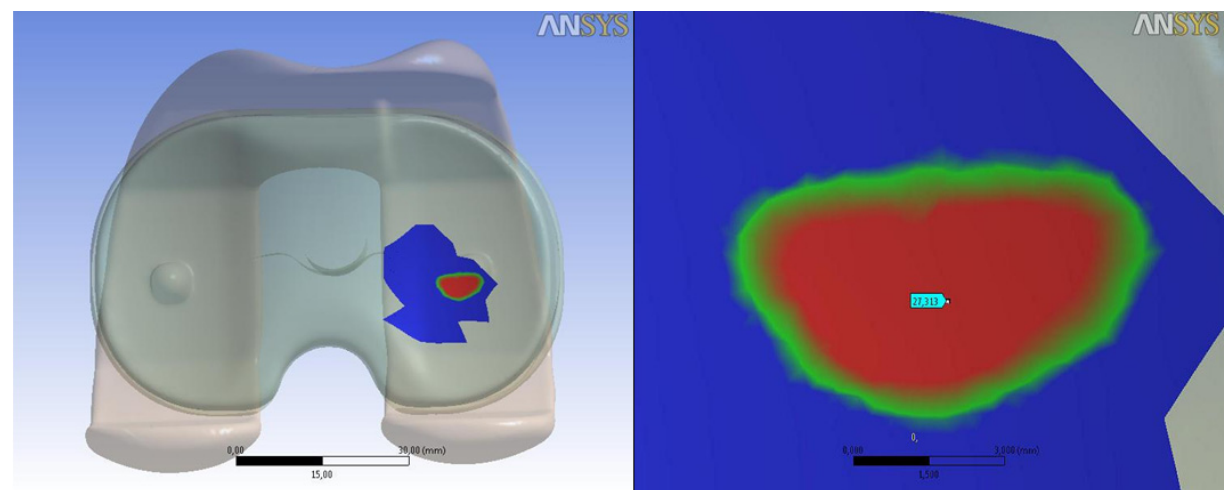
Figura 9: Configurazione a 0°: area di contatto e pressione massima. Figure 9: Configuration at 0°: contact area and maximum pressure.